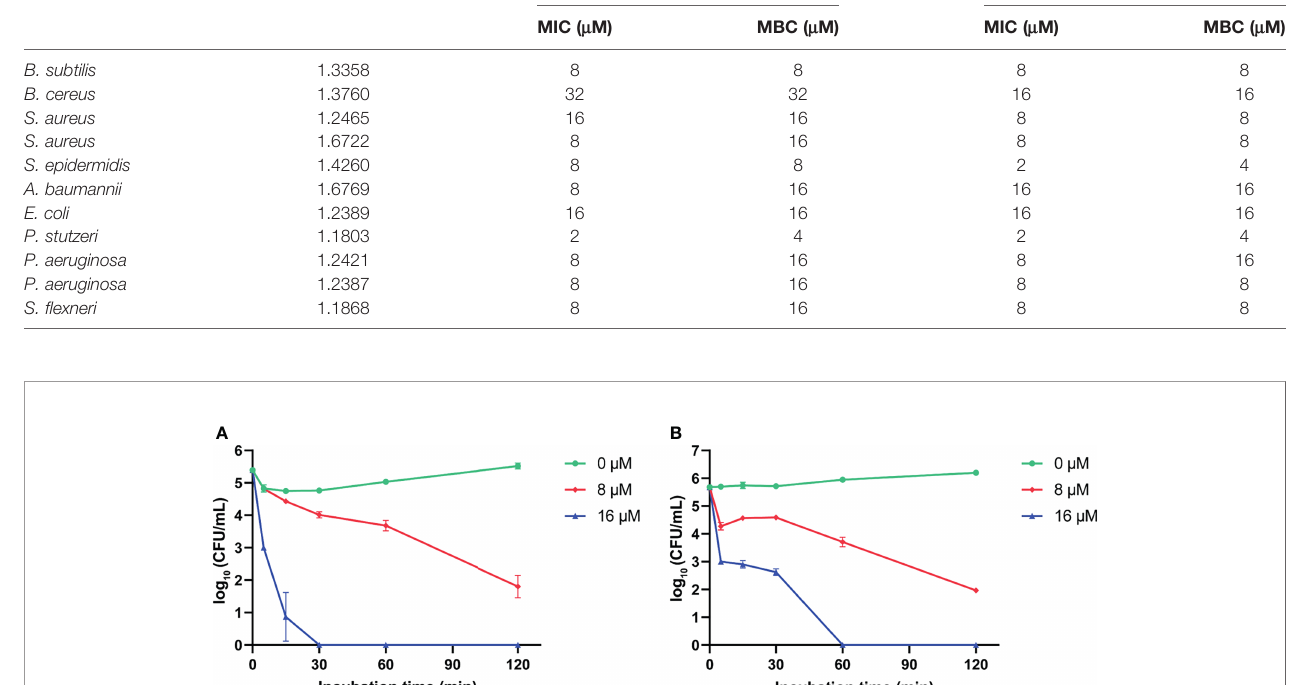
TABLE 2 | The MIC values of AS-hepc3 (41-71) and AS-hepc3 (48-56) against different microorganisms. Microorganism